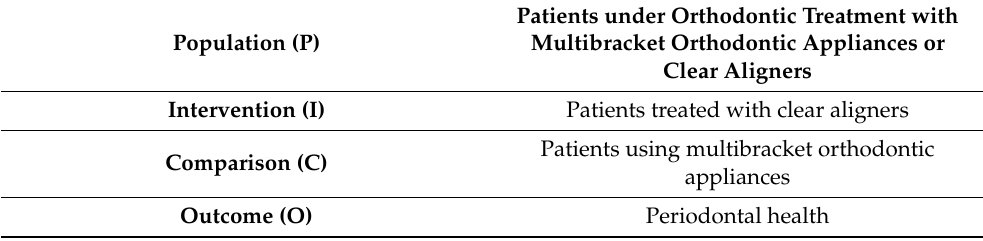
Table 1. Description of the search strategy under PICO method. Patients under Orthodontic Treatment with Population (P) Multibracket Orthodontic Appliances or Clear Aligners Intervention (I) Patients treated with clear aligners Patients using multibracket orthodontic Comparison (C) appliances Outcome (O) Periodontal